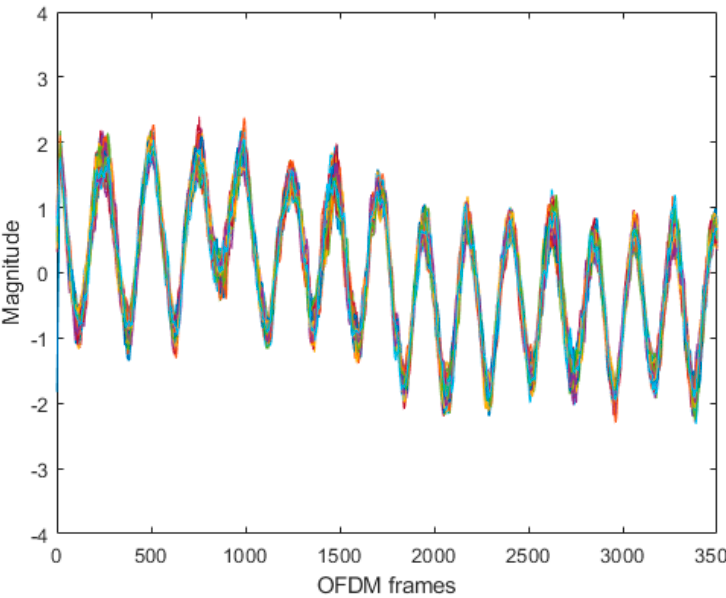
Figure 11. Magnitude response of normal breathing experiment.